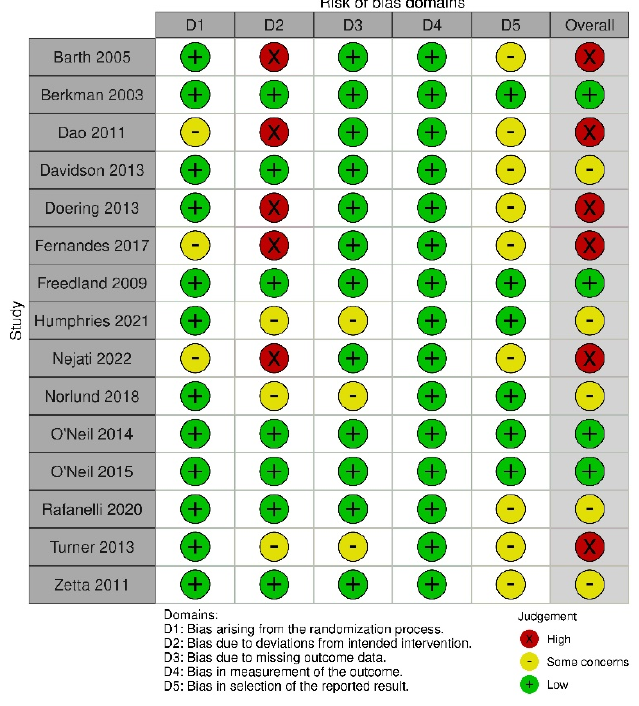
Figure 2. Risk-of-bias assessment Figure 2. Risk ‐ of ‐ bias assessment [29–39,41–43,47].